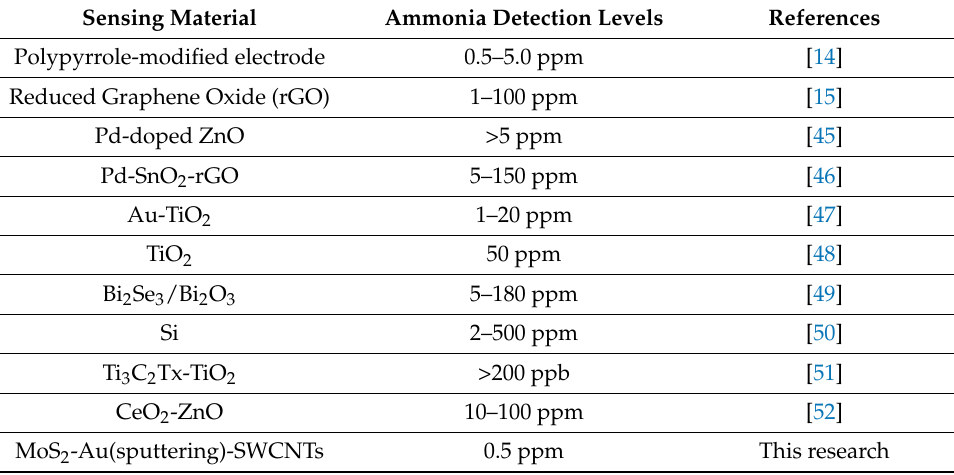
Table 1. Comparison of the results obtained in the present research with other ammonia sensors.